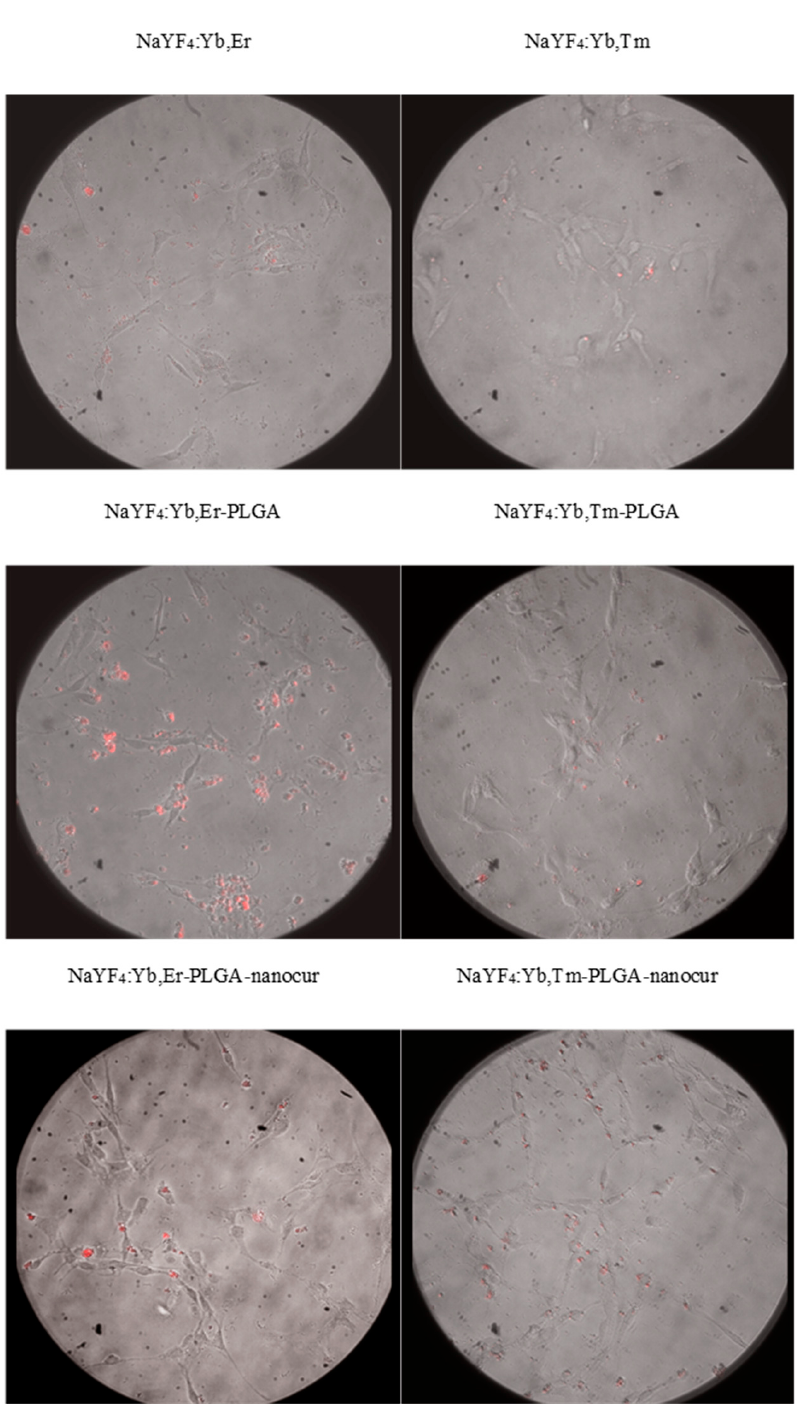
Figure 11. Micrographs of rat C6 glioma cells in an upconverting luminescence microscope: UCNPs concentration 0.05 mg/mL, 30 min of incubation. The upconversion signal is in red. Lens 10×.